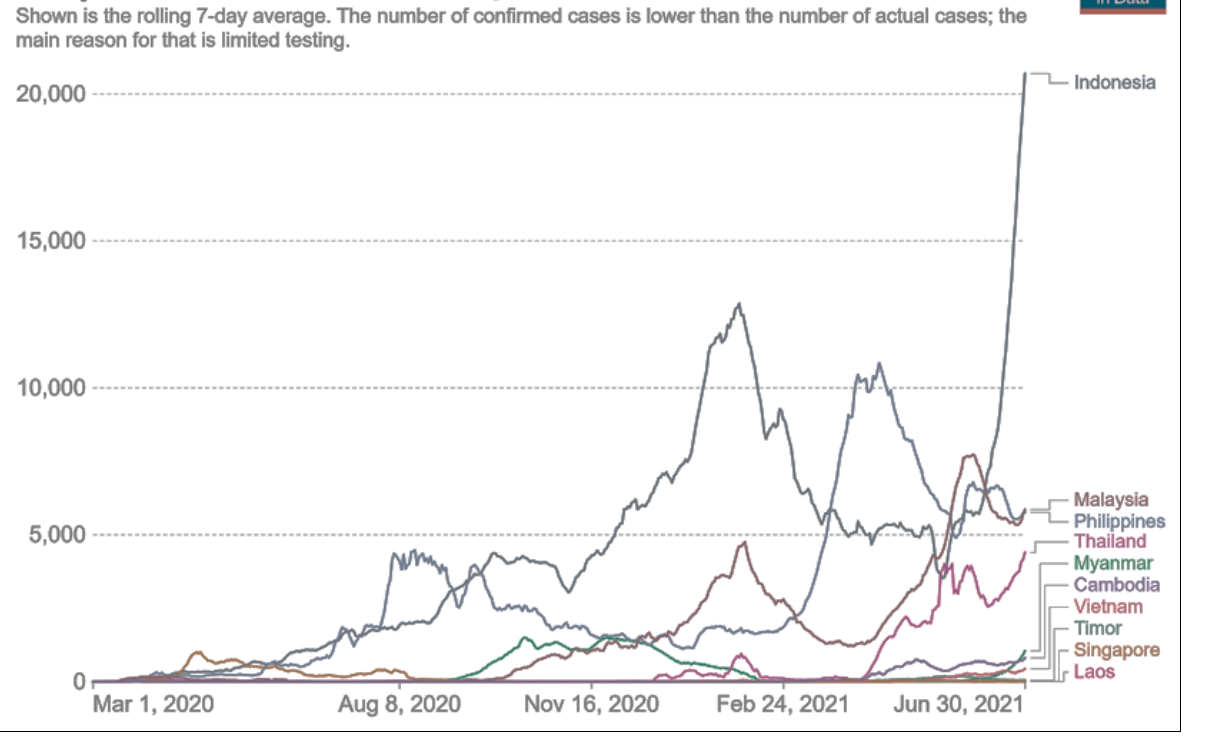
Figure 1. Daily new confirmed Covid-19 deaths and cases in Southeast Asia-Source: https://ourworldindata.org–